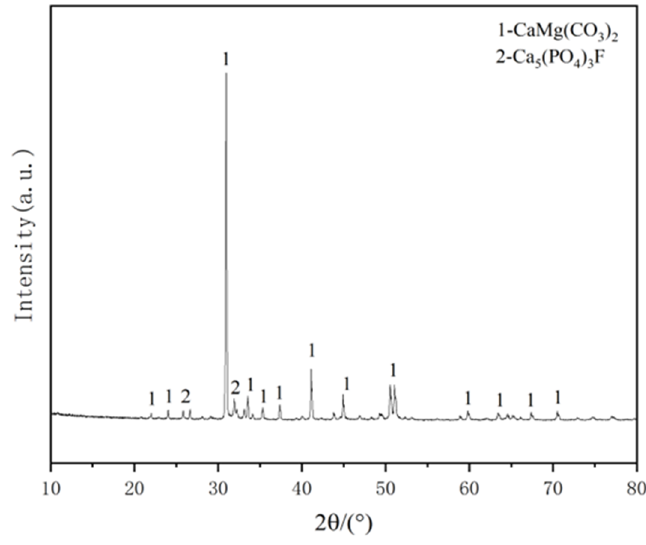
Figure 3. XRD pattern of phosphorus tailing micro-powder.